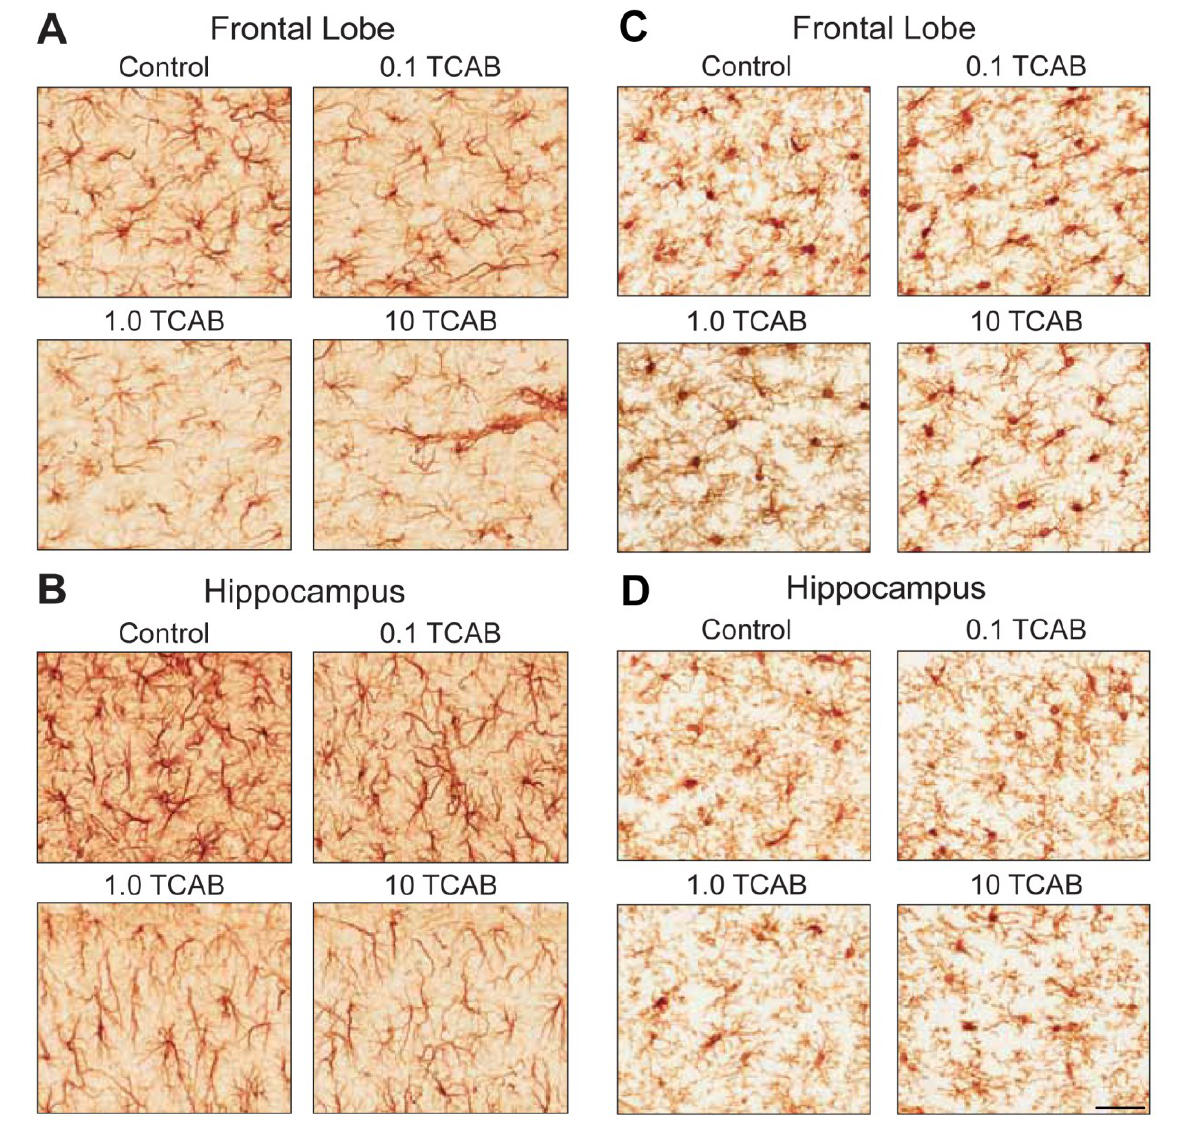
Figure 9. Representative image of glial fibrillary acidic protein (GFAP) + astrocytes and Iba-1+ microglia (DAB brown staining) at PND21 within the ( A , C ) frontal lobe and ( B , D ) hippocampus of control and 0.1, 1.0, and 10 mg/kg/day TCAB developmentally exposed rats. Astrocytes displayed densely stained processes in controls and 0.1 mg/kg/day groups. In the 1.0 and 10 mg/kg/day groups, cells displayed thin processes and less branching complexity. Microglia exhibited complex and dense process extensions. These processes were less complex in the 10 mg/kg/day dose group resulting in diminished immunoreactivity product between cell bodies. Scale bar = 10 μm. ( E ) Ranking of cell soma shape, orientation, density, and complexity of processes. Percentage of each stage for astrocytes in the ( F ) FL and ( G ) ML Microglia in the ( H ) FL and ( I ) ML. Data represents mean ± SD. * p < 0.05; ** p < 0.01 as compared to